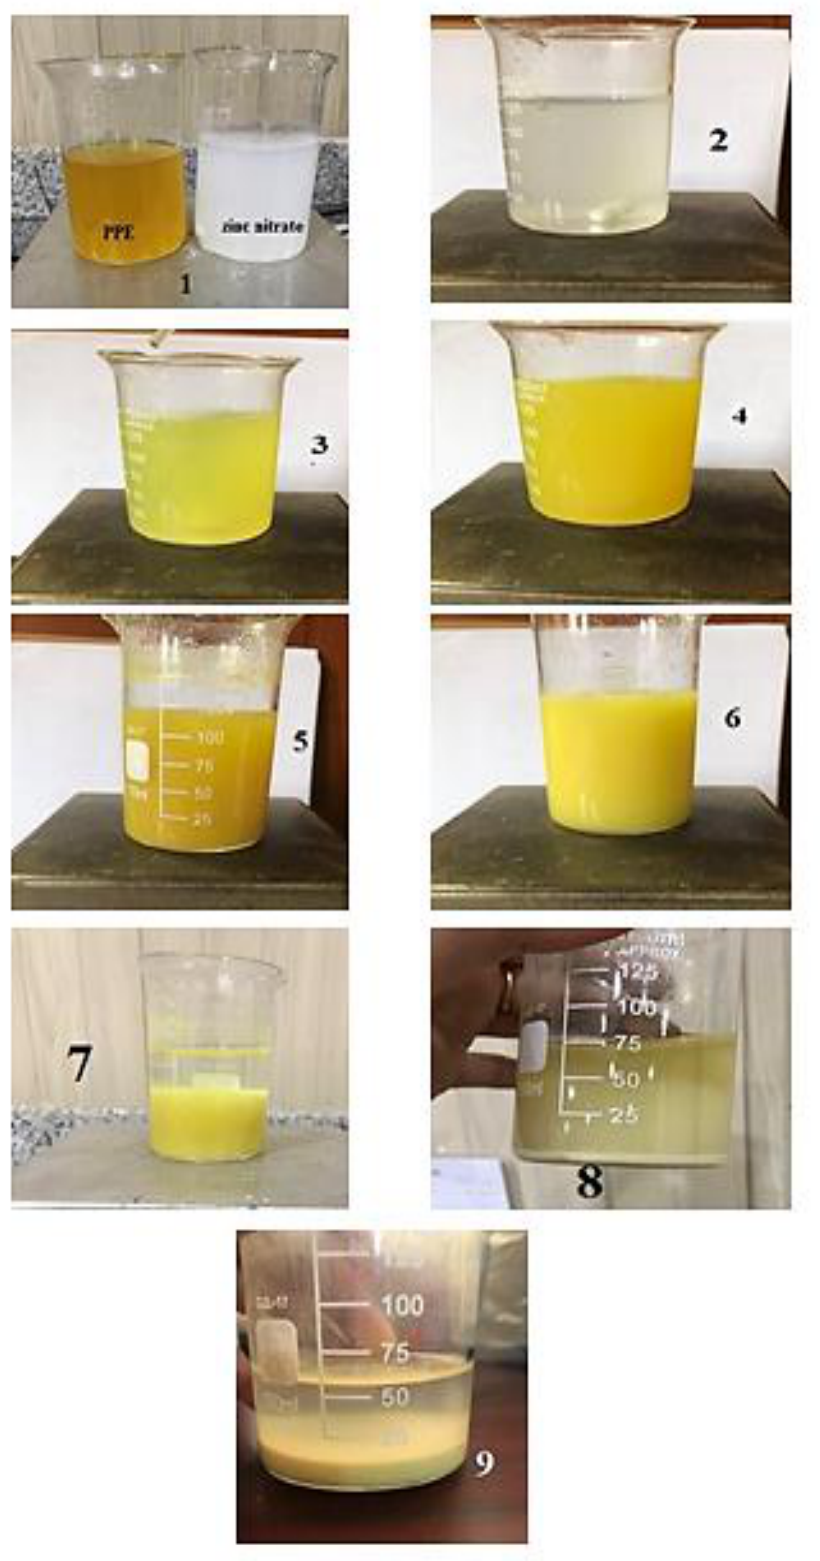
Figure 1. The final form of precipitation after 8 hours from mixing of zinc nitrate with PPE according to steps of green synthesis of ZnONPs from